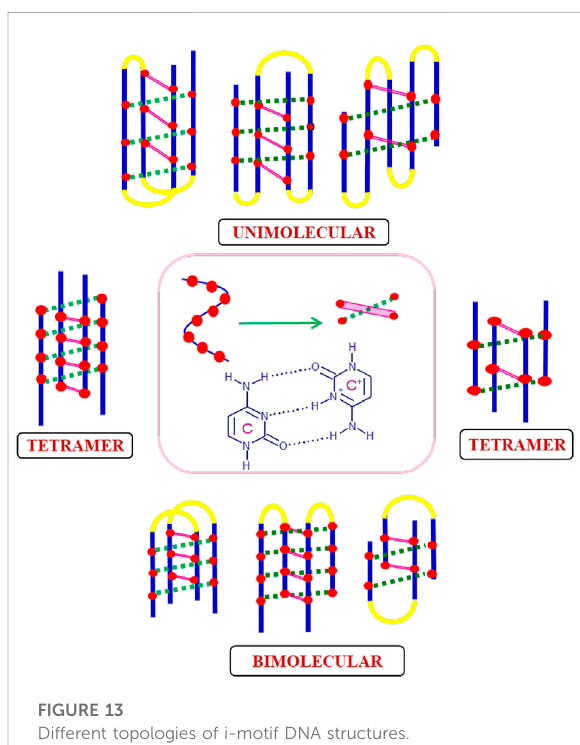
FIGURE 13 Different topologies of i-motif DNA